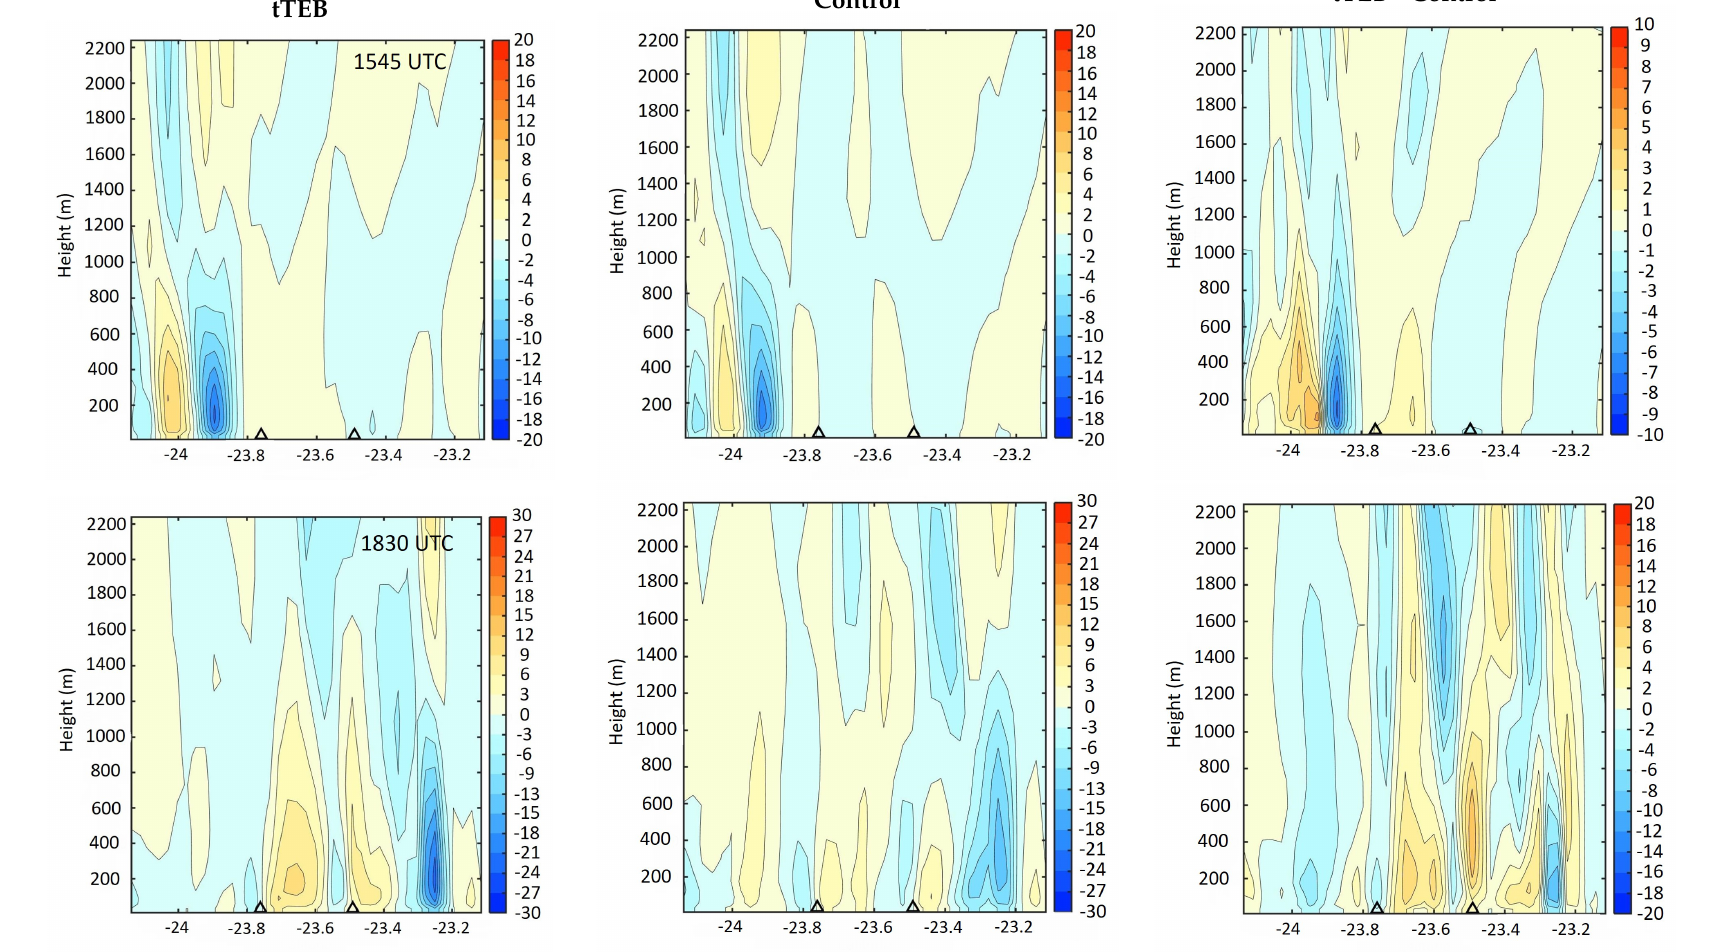
Figure 15. Vertical cross section of the mean moisture divergence flux ( × 10 − 4 g kg − 1 s − 1 ) between 46.90 ◦ W and 46.42 ◦ W at 1545 UTC (1245 LT) (first row) and 1830 UTC (1530 LT) (second row) along the latitude. The figure shows the results of the tTEB experiment (first column), control experiment (second column) and the differences between both experiments (third column). Triangles indicate the extension of the urban area of the